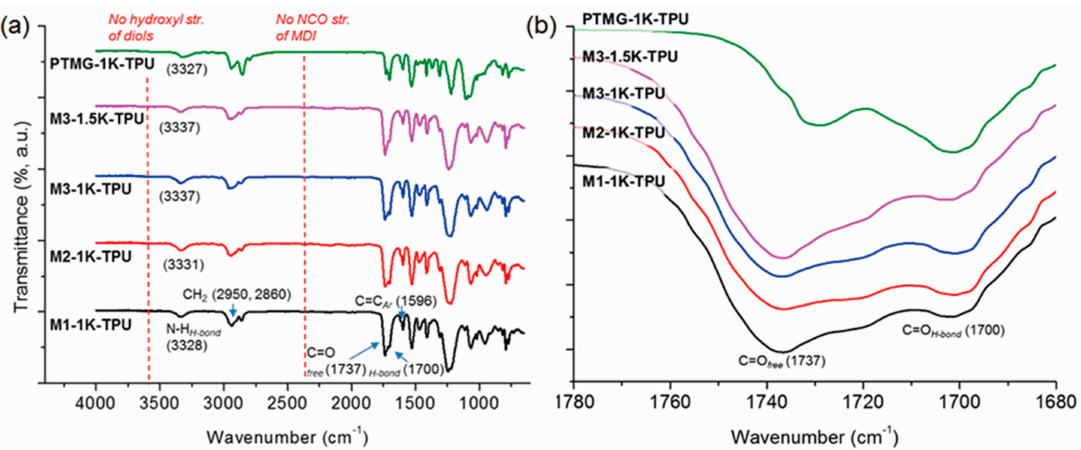
Figure 4. ATR-FTIR spectra of TPUs (( a ) full range; ( b ) enlarged range to carboxyl stretchings).